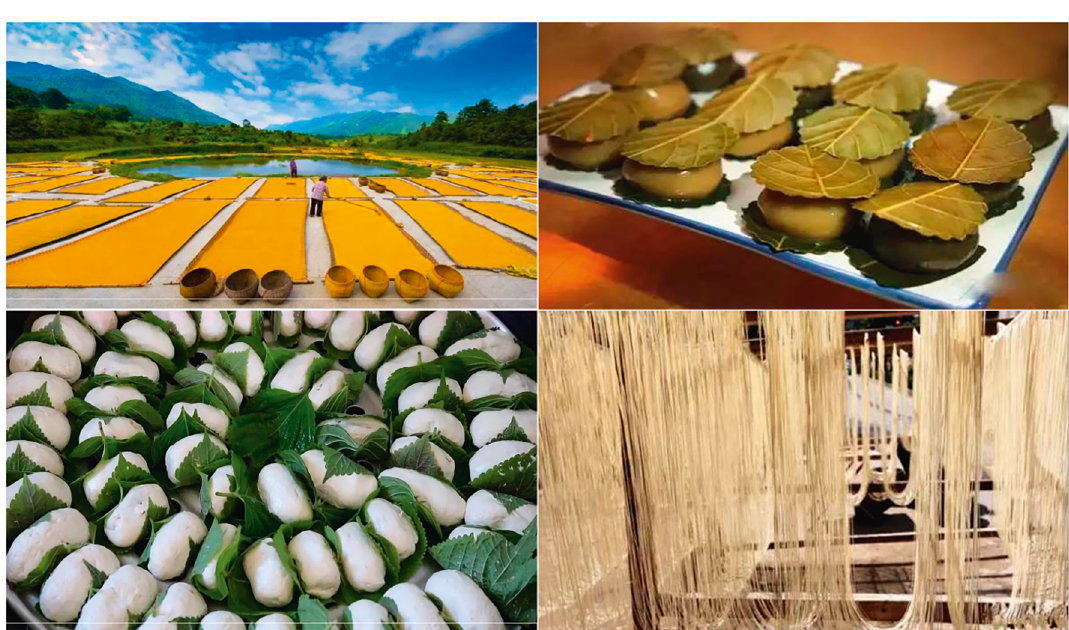
Figure 2: Unique country